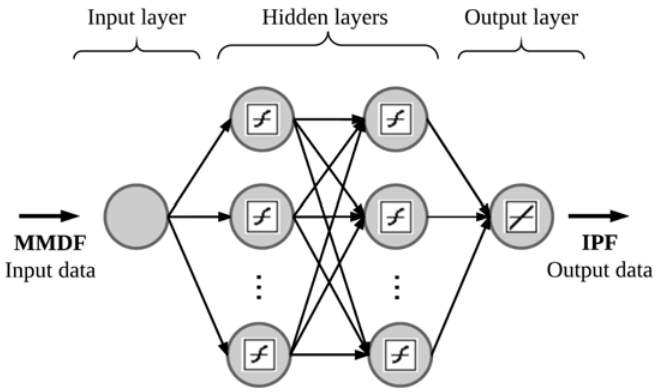
Figure 2. Structure of feedforward multilayer perceptron network (MLP) network used in this research